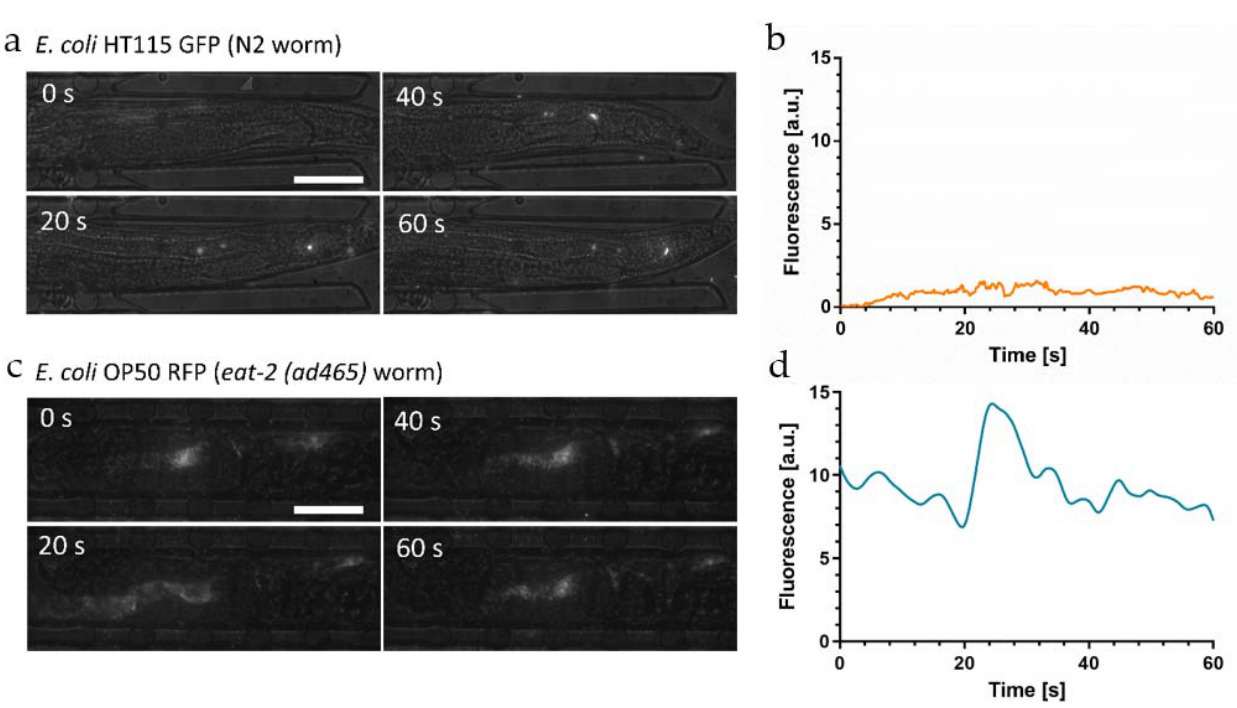
Figure 4. Intact vs. disrupted bacteria in the C. elegans intestine. Images and corresponding graphs are shown for a single representative worm for each condition. ( a ) High-resolution brightfield/fluorescence (50×) time-lapse images of an immobilized N2 C. elegans worm fed E. coli HT115 GFP. The image sequence shows a few intact bacteria passing through the hindgut region. Despite the pH sensitivity of GFP, fluorescence of intact bacteria is not affected by the acidic environment. Diffuse signals from disrupted bacteria that have lost membrane integrity cannot be observed due to fading of the GFP signal. ( b ) Fluorescent signal as a function of time measured in the worm in ( a ), showing a low but relatively constant GFP level originating from intact bacteria. ( c ) High-resolution time-lapse images of an immobilized C. elegans eat-2 ( ad465 ) mutant fed E. coli OP50 RFP. eat-2 ( ad465 ) mutants tend to accumulate intact bacteria in the posterior region of the intestine. The resulting fluorescent signal may be associated to a mixed load of intact and grinded bacteria, as the RFP marker is not affected by the low pH in the hindgut. ( d ) Time evolution of the fluorescent signal measured in the worm in ( c ). Overall, the fluorescence remains on a constant high level on a time scale relevant for food processing due to the stable presence of intact bacteria in the gut. The peak at t ∼ 25 s is due to ingestion and subsequent digestion of a new bacterial aliquot. Scale bars = 50 μ m.